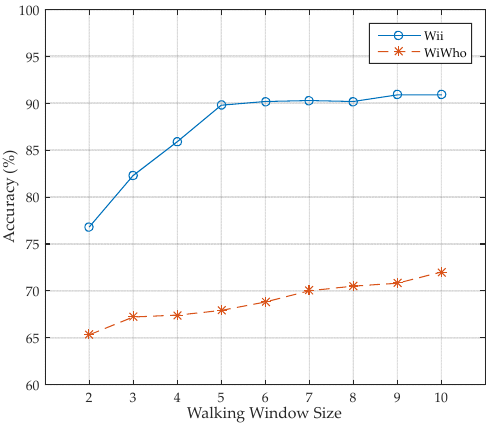
Figure 14. Impact of walking window size.